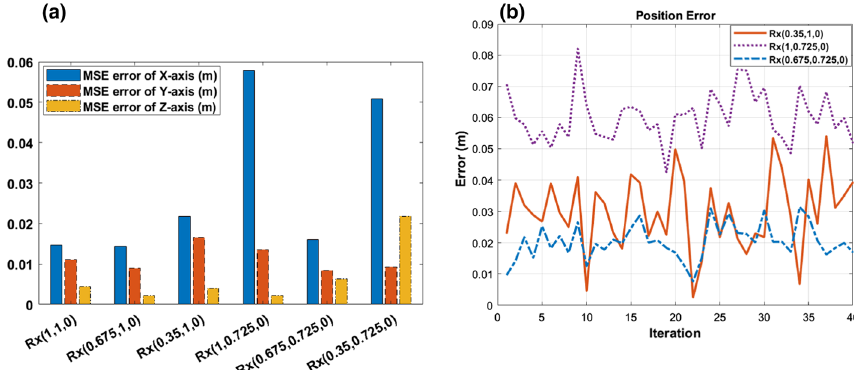
Fig. 7 Mean square error (MSE) of x, y, z for selected Rx position ( a ) and combined error or three receiver positions over 40 measurements ( b